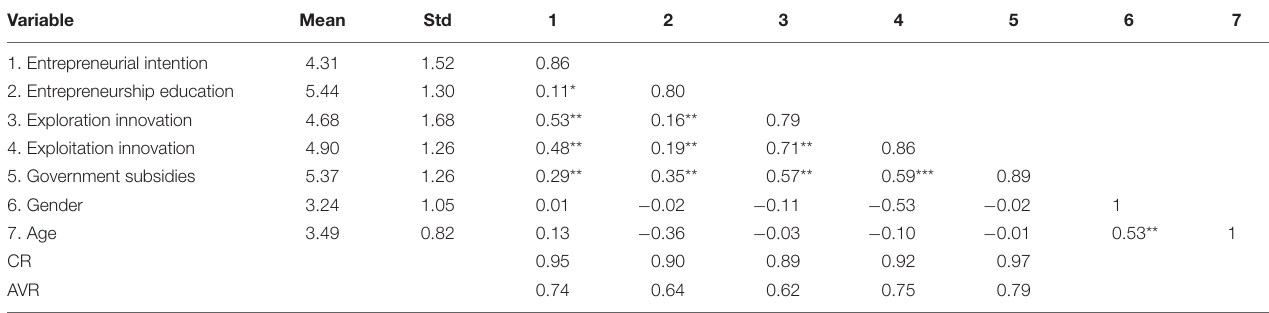
TABLE 2 | Basic descriptive statistics of the correlation coefficients. Variable Mean